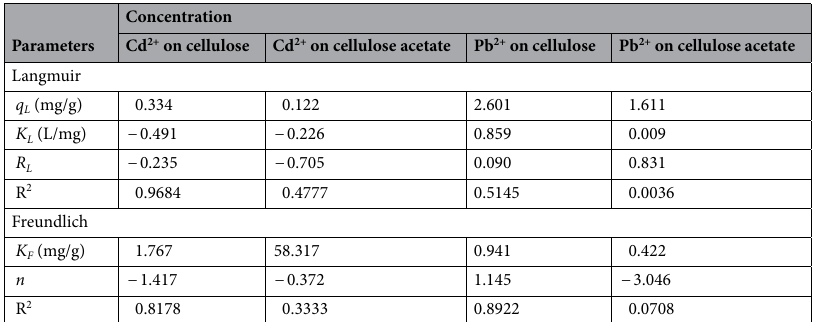
Table 7. Equilibrium isotherm parameters for cadmium and lead ions adsorption on cellulosic material surfaces.